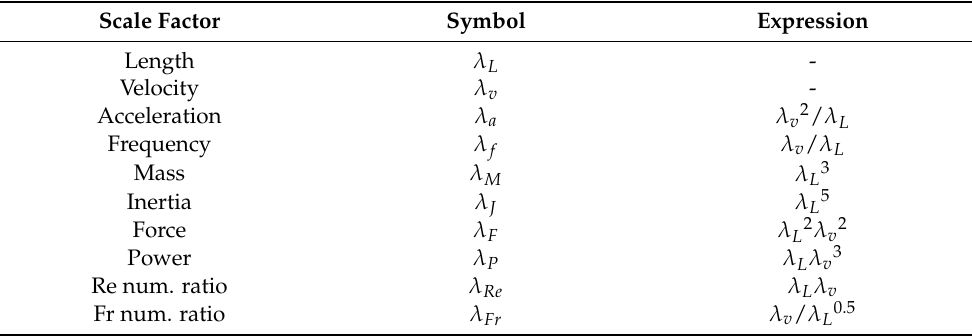
Table 1. Factors as a function of the length and velocity for a generic scaling law. Scale Factor Symbol Expression Length λ L - Velocity λ v - Frequency λ f λ v / λ L Mass λ M λ L 3 Inertia λ J λ L 5 Force λ F